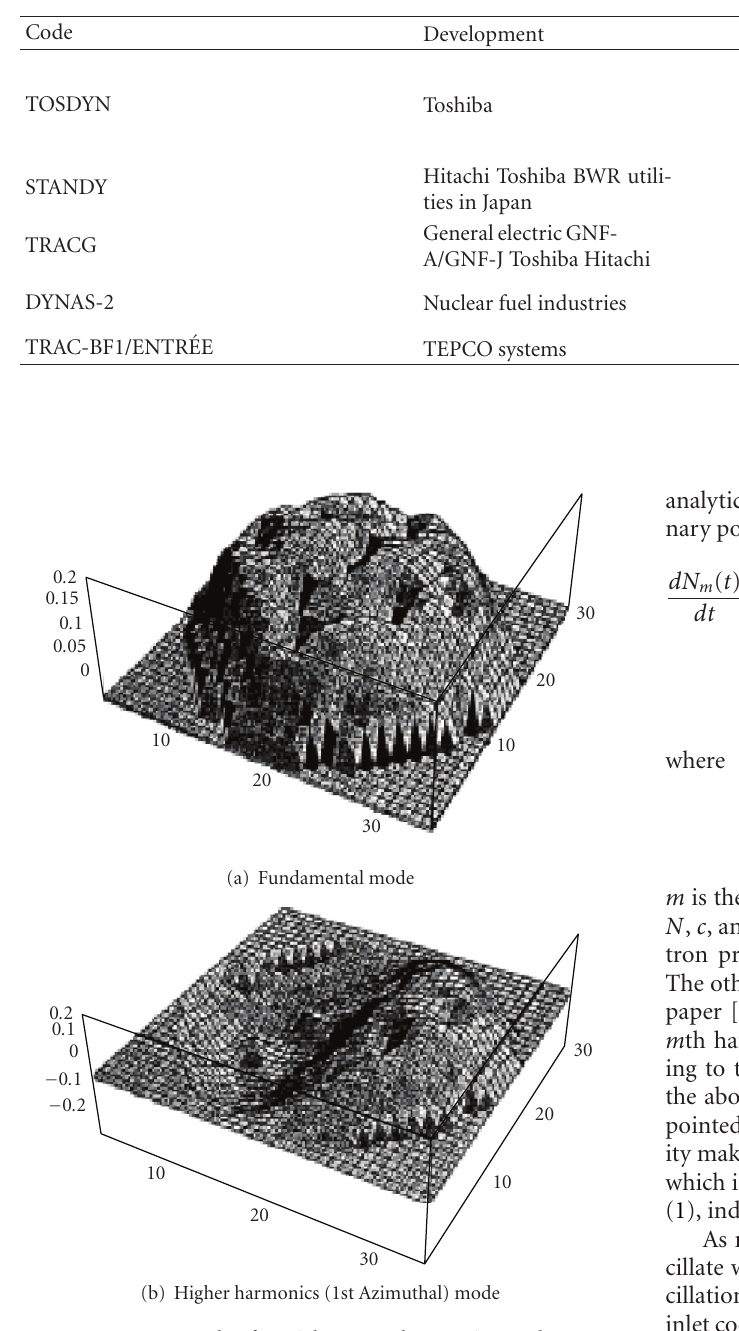
Figure 4: Sample of spatial neutron harmonics modes.